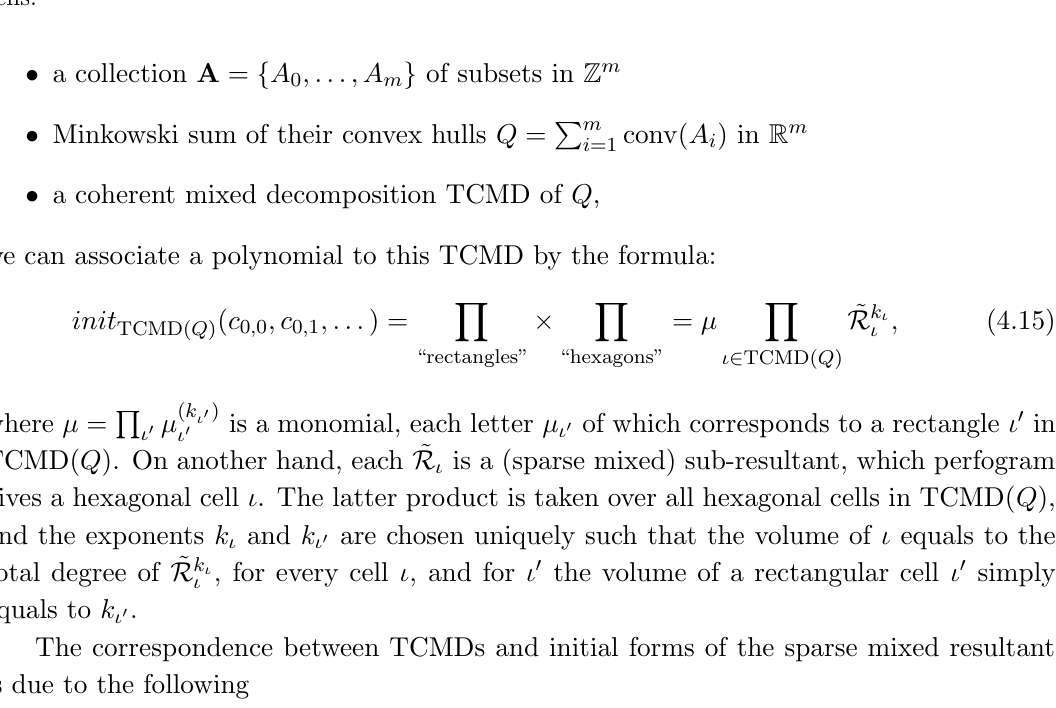
Figure 8 . This TCMD gives rise to the initial form (4.16), computed as the product over all its